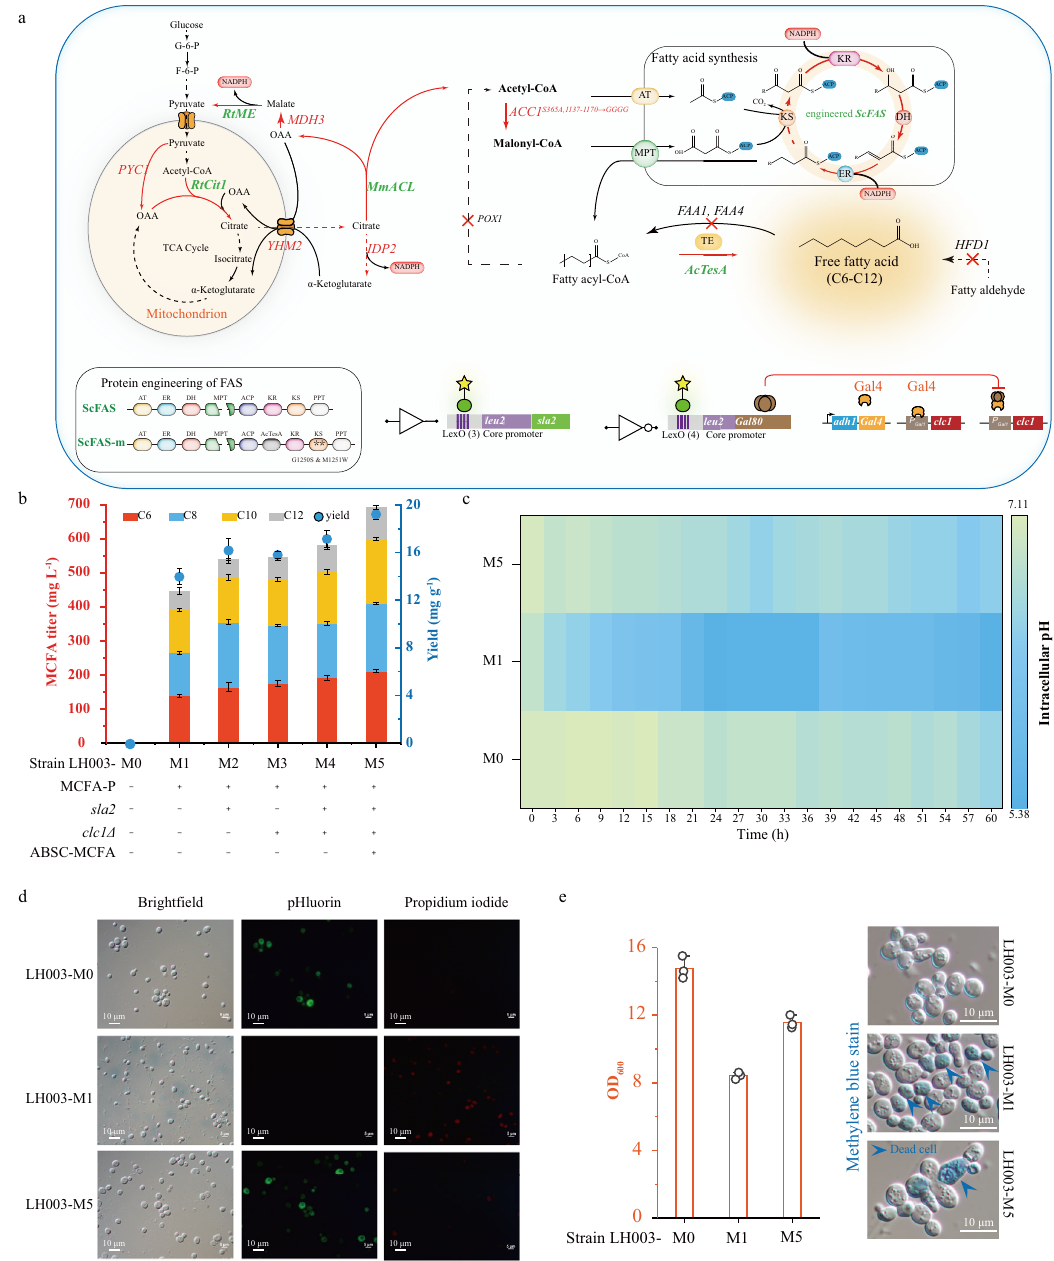
Fig. 6 Increasing MCFAs production through increasing cell growth. a The schematic diagram of medium-chain fatty acid production. The red arrows indicate the enhancement of carbon fl ux into medium-chain fatty acids. The thioesterase Ac TesA was inserted into fatty acid synthase, and the location of Ac TesA was adjacent to the acyl carrier protein. Meanwhile, two mutations (G1250S and M1251W) were performed in Fas2. MCFA-P means MCFAs pathway. b MCFA production of different engineered strains in shake fl ask culture. The histogram graphs were the titer (C6-C12) of different engineered strains, whereas the round symbols were the yield of the corresponding engineered strains. c The intracellular pH of strain LH003-M0, LH003-M1, and LH003-M5 during the MCFAs production. LH003-M0 strain was the control strain without the MCFAs pathway and two-phase damage buffer. LH003-M1 strain was only harbored the MCFAs pathway, whereas the LH003-M5 strain was both harbored the MCFAs pathway and the autonomous two-phase damage buffer. d The microscopy images of strain LH003-M0, LH003-M1, and LH003-M5 during the MCFAs production. e The cell density (OD 600 ) was analyzed in LH003-M0, LH003-M1, and LH003-M5 strain, respectively. Additionally, methylene blue was applied to stain the dead cells. b , c , e Values and error bars represent the mean values and standard deviations of three biological repeats, respectively. d , e Three experiments ( n = 3) were repeated independently with similar results. Source data are provided as a Source Data fi le. better solution to adjust microbial cells to intracellular or extra- ef fi cient microbial cell factory, static strategies (e.g., promoter cellular changes 59 . These genetic circuits consist of a sensing engineering 56 and modular engieering 57 ) are not suf fi cient to enable microbial cells to adapt to the stochastic metabolic per- module, a processing module, and an output module, with the turbations and a polytropic fermentation environment 58 . There- former two modules deciding the utility and ef fi ciency. (i) The sensing module: the biosensor senses the intracellular (e.g., pH i 60 , fore, autonomous decision-making genetic circuits may be a NATURE COMMUNICATIONS| (2022) 13:1886